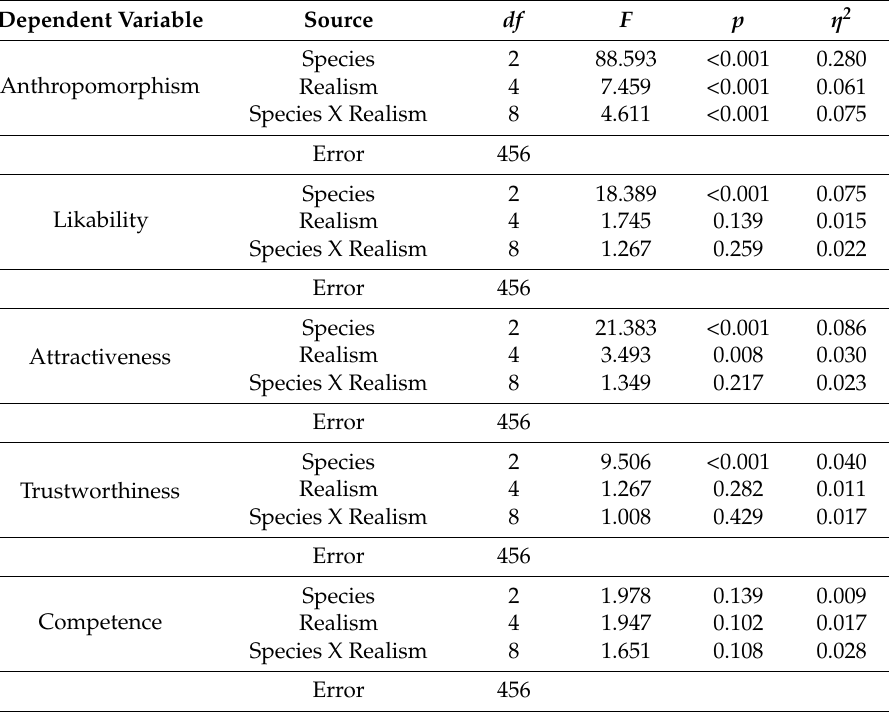
Table 7. Results of MANOVA with regard to person perception.